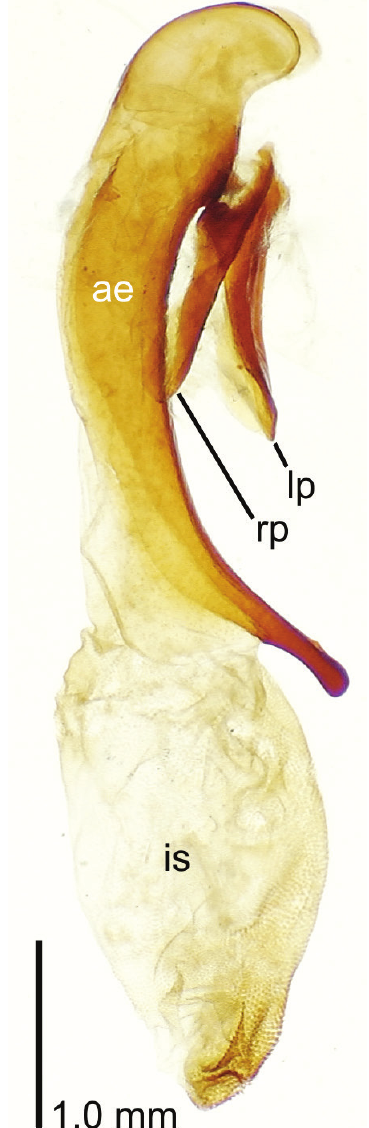
Figure 4. Male aedeagus, internal sac everted, of Bryanites graeffii male holotype, right lateral view. Abbreviations in- clude: ae, aedeagal median lobe; is, internal sac; lp, left param- ere; rp, right